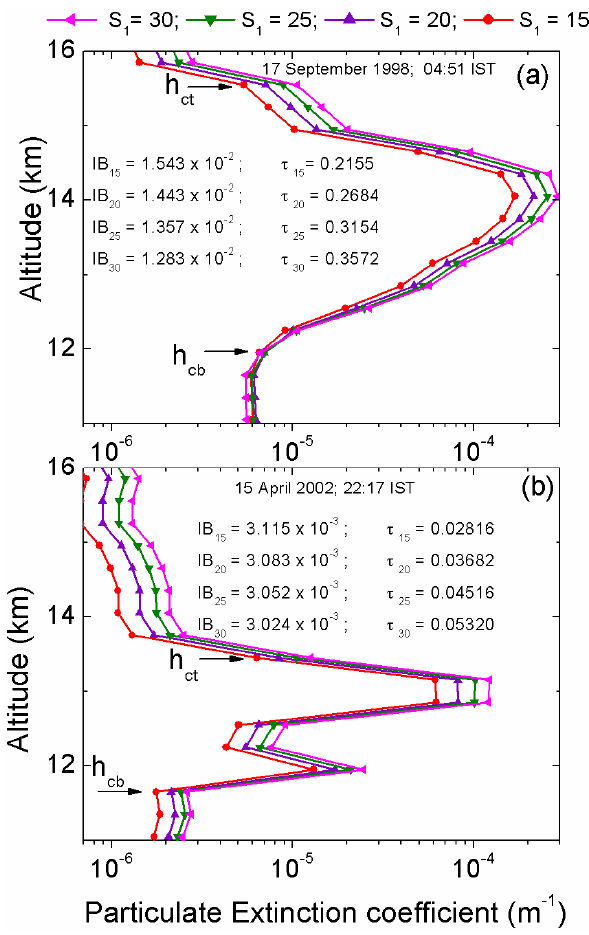
Figure 1 Fig. 1. Altitude profiles of particulate extinction coefficient with thick and thin cirrus for different values of lidar ratio S 1